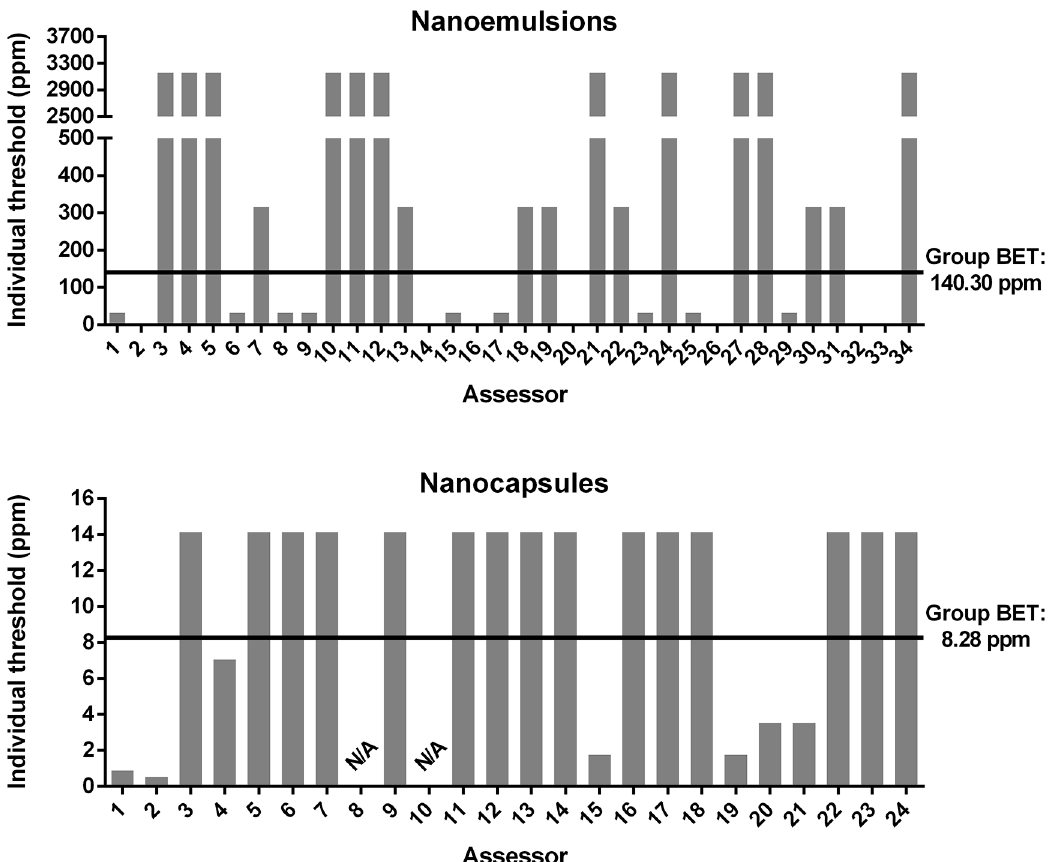
Fig 4. Individual best estimate threshold (BET) of unloaded nanoformulations. Individual BET of each panelist in comparison to the group BET for the unloaded nanoemulsion and